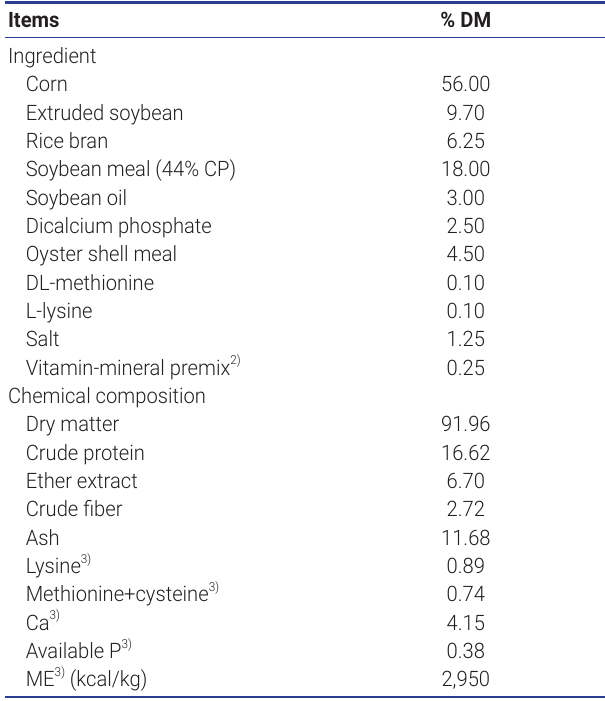
Table 1. Feed ingredients and chemical composition of the basal diet